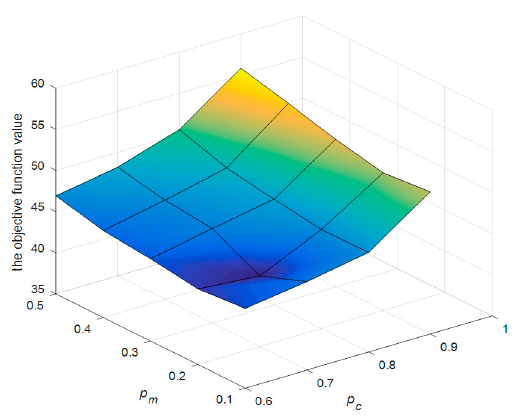
Figure 15. The objective function value for different crossover and mutation probabilities.